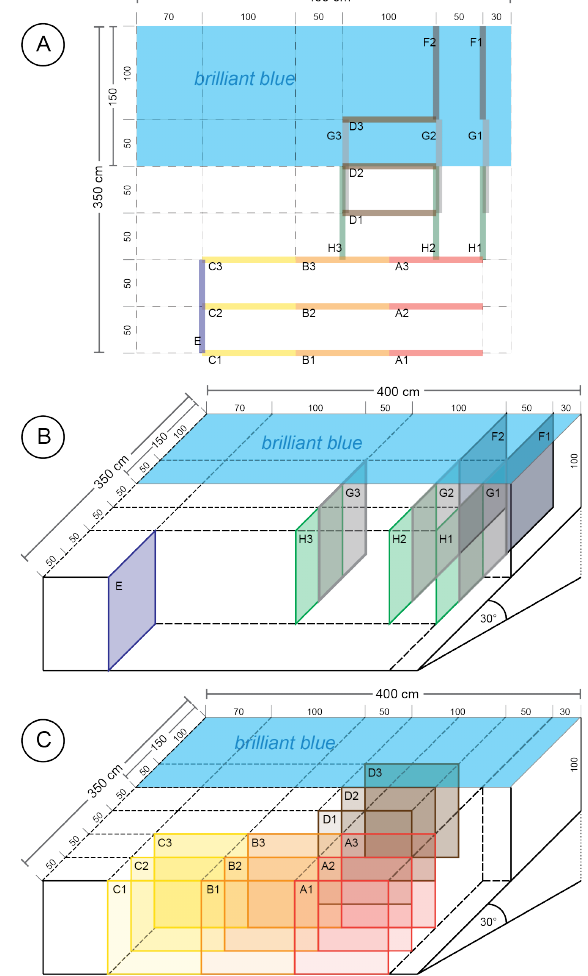
Fig. 2 Dye tracer experiment overview. (A) 2-D top view of the 1.5 m x 4 m brilliant blue dye 2 Fig. 2. Dye tracer experiment overview. (A) 2-D top view of application plot with 1 m x 1 m profiles excavated on 02.-05.11.2011. (B) 3-D diagram of the 1 m x 3 the 1.5m × 4m brilliant blue dye application plot with 1m × 1 m lateral (= parallel to slope’s gradient) dye-stained profiles A1-A3, B1-B3, C1-C3 and D1-D3. (C) 4 3-D diagram of the 1 m x 1 m frontal (= perpendicular to slope’s gradient) dye-stained profiles E, H1- 5 H3, G1-G3 and F1-F2. 6